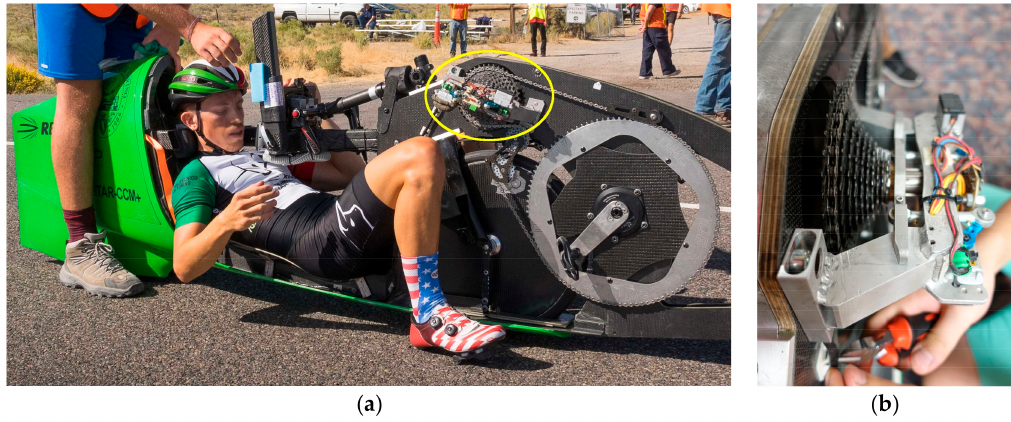
Figure 4. First prototype of the moving cassette: ( a ) the HPV Taurus at the WHPSC 2017 with the first moving cassette shifter on the right side (photo courtesy of F. Corda); and ( b ) close-up view (photo courtesy of J.